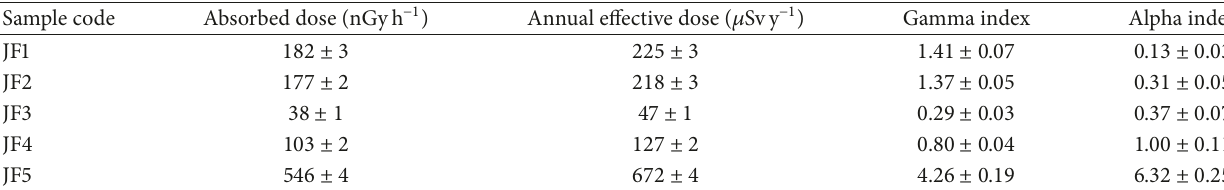
Table 6: Absorbed and annual effective dose and hazard indexes of fertilizers used in